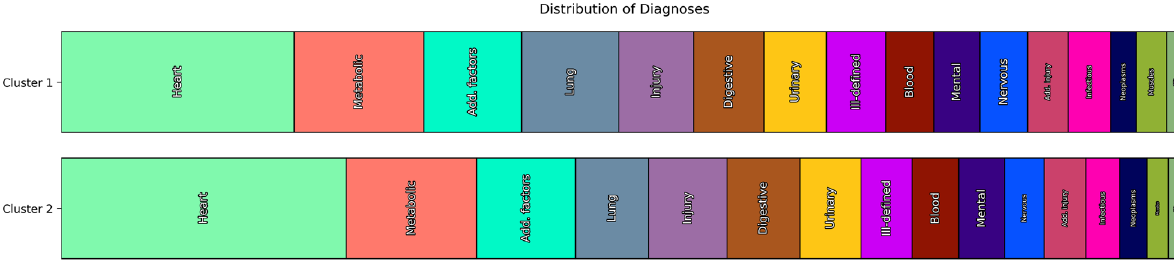
Figure 3. Distribution of ICD categories within the coarse clustering ( k = 2 ). For each clustering, we examine every diagnosis code assigned to any patient and count it towards the ICD group to which it belongs. Every diagnosis is counted, even if a single admission exhibits multiple diagnoses from the same ICD category. Typically, patients suffer from conditions in multiple ICD categories, so most patients contribute to multiple categories. Note that total diagnosis counts are different between clusters, but the bars in the figure are normalized to the same length to enable an easier